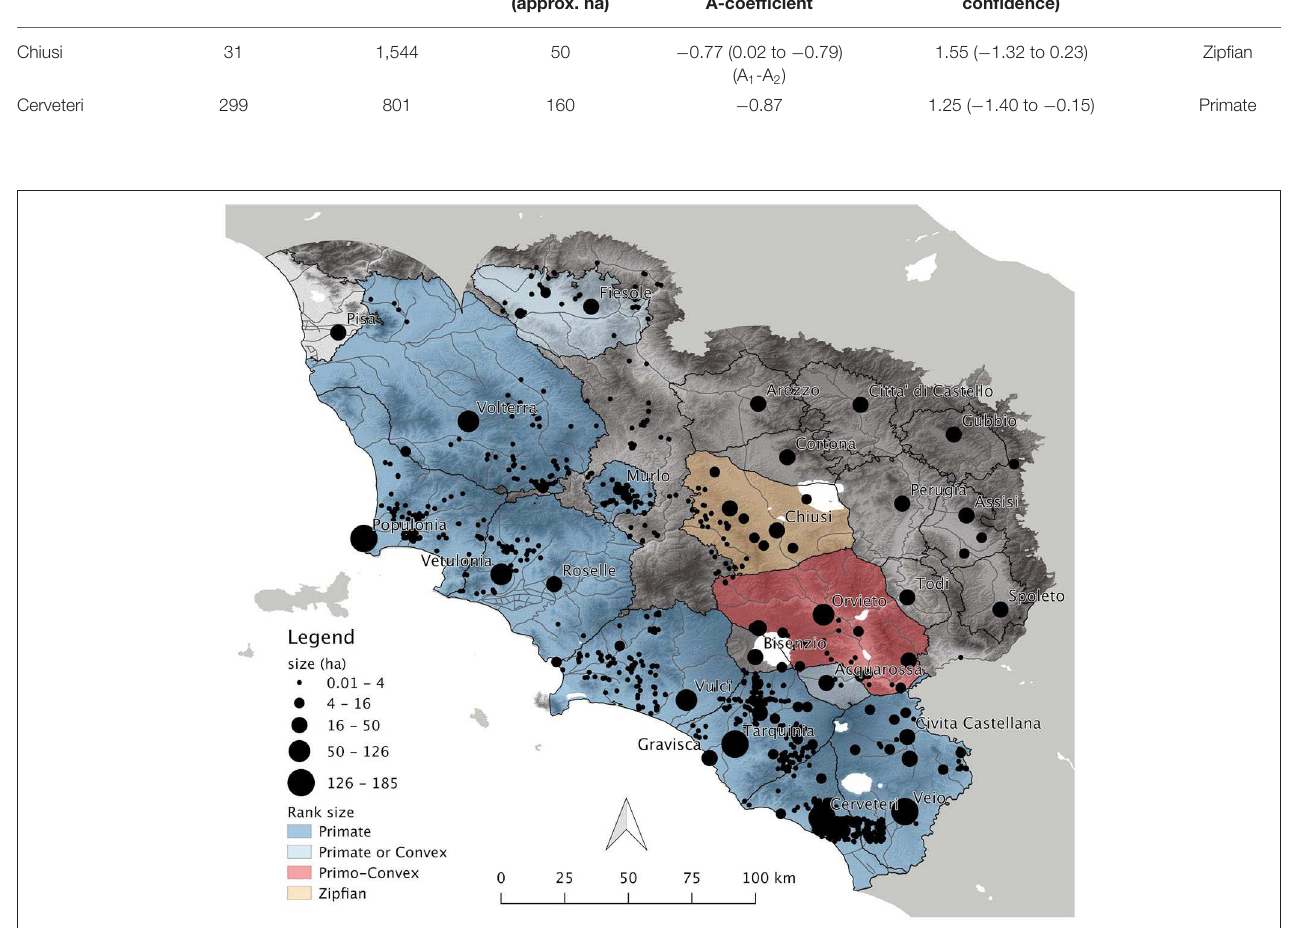
TABLE 14 | A-coefficient values and bootstrapped error ranges for log scale rank-size curves of the XTENT-defined territories for updated data for Chiusi and Cerveteri in the Archaic period. See Figure 12B for reference. Territory No. sites